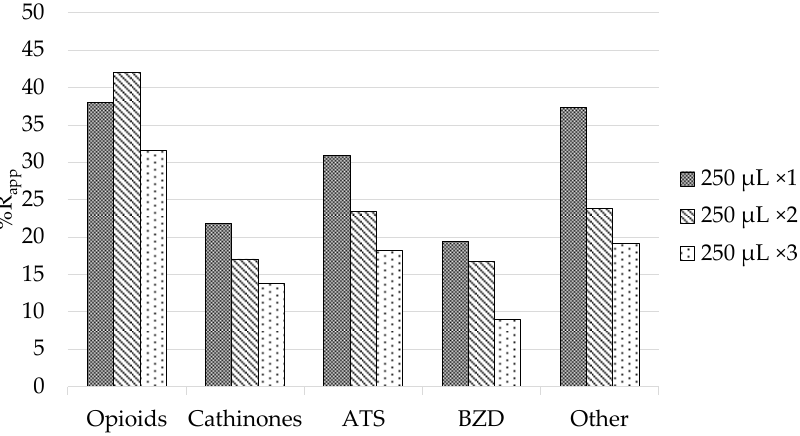
Figure 4. Evaluation of different aspirating/dispensing loading cycles of urine:H 2 O at pH 4 (50:50, v/v ) at a spiked concentration of 50 ng mL − 1 .